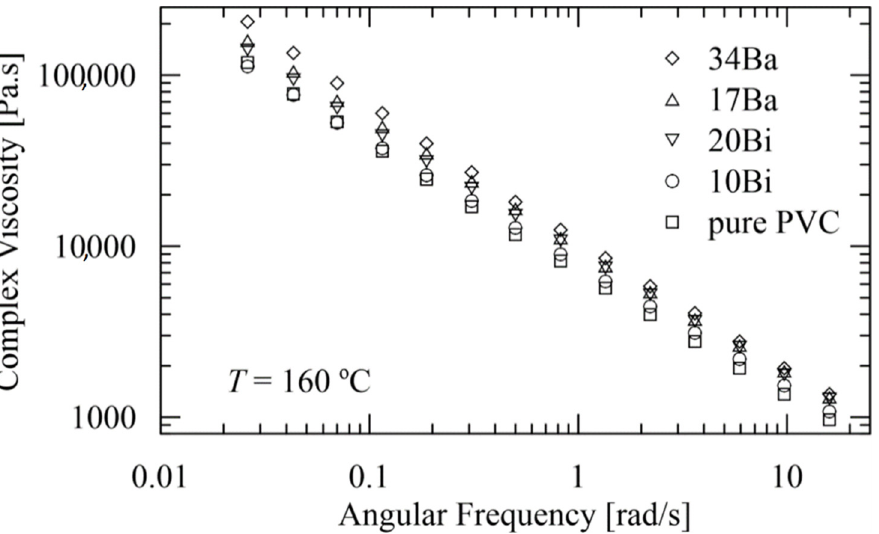
Figure 3. Complex viscosities of the composites and pure PVC matrix as a function of angular frequency at a temperature of 160 °C. frequency at a temperature of 160 ◦